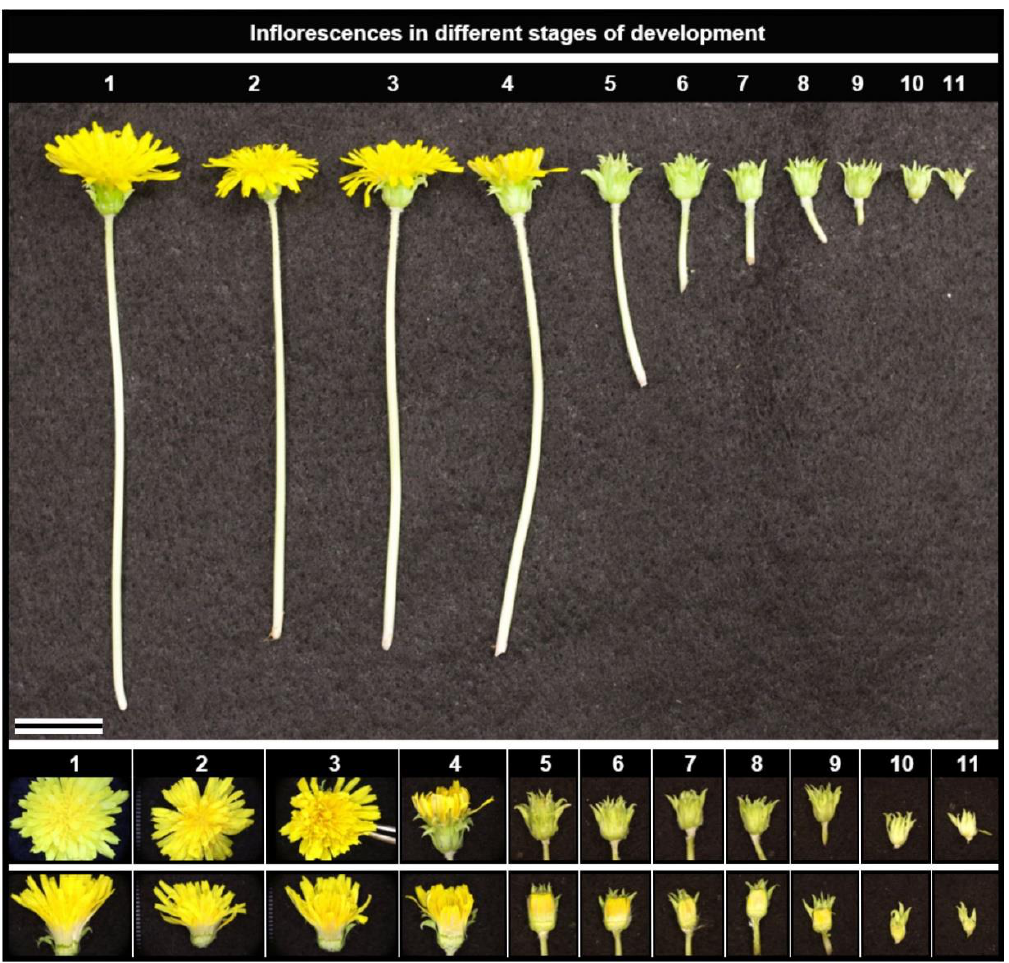
Figure 6. Different stages of morphological inflorescence development in Taraxacum kok-saghyz , showing inflorescences 1 to 11 in the same plant. The 20 mm scale bar represents the size in all the figures.